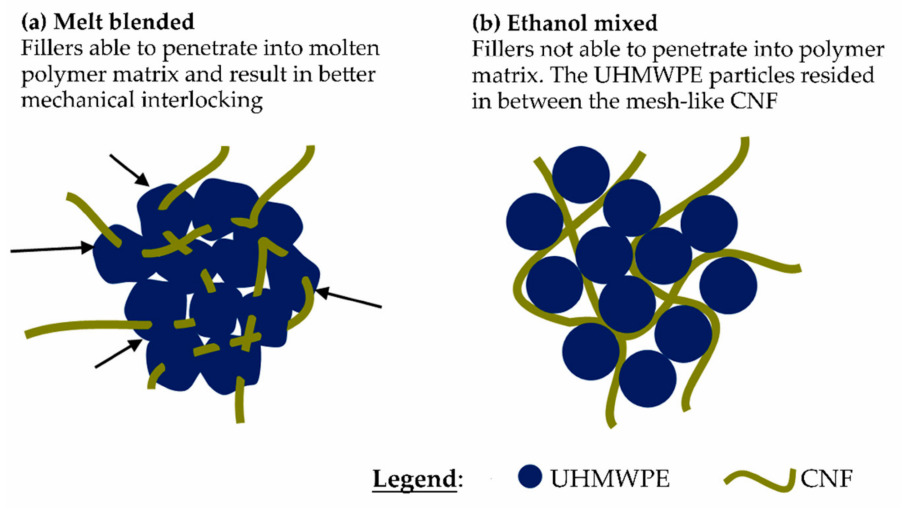
Figure 8. Illustration of CNF interaction with UHMWPE matrix in ( a ) melt blended (MB- UHMWPE/0.5) and ( b ) ethanol mixed (EM-UHMWPE/0.5)